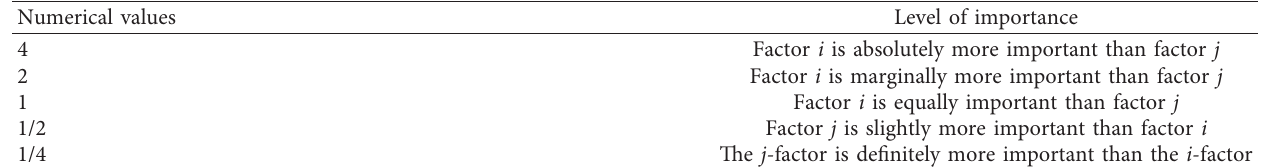
Table 2: Two-by-two comparison of the improved “five-scale